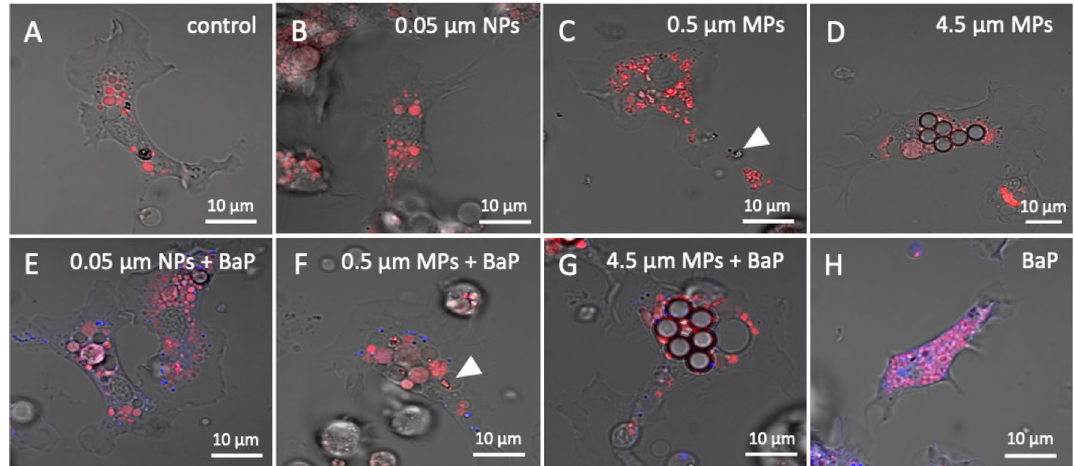
Figure 2. Confocal fluorescence microscope images showing lysosomes (red) and BaP (blue) in hemocytes exposed to 0.05 μm NPs (10 12 part./mL) and to 0.5 and 4.5 μm MPs (10 8 and 10 9 part./mL, respectively) alone or in combination with BaP and to BaP alone. Arrowheads indicate structures resembling aggregates of 0.5 µm